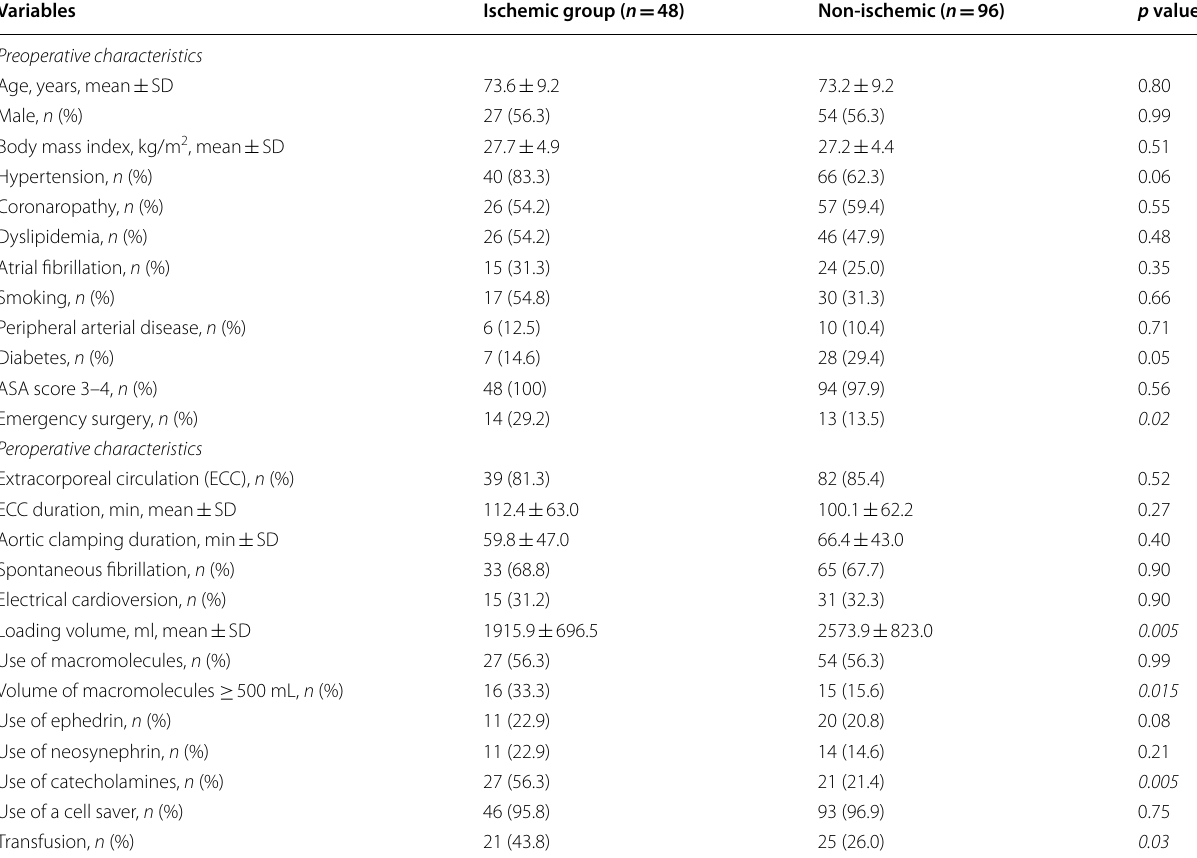
Table 1 Patients preoperative and peroperative characteristics